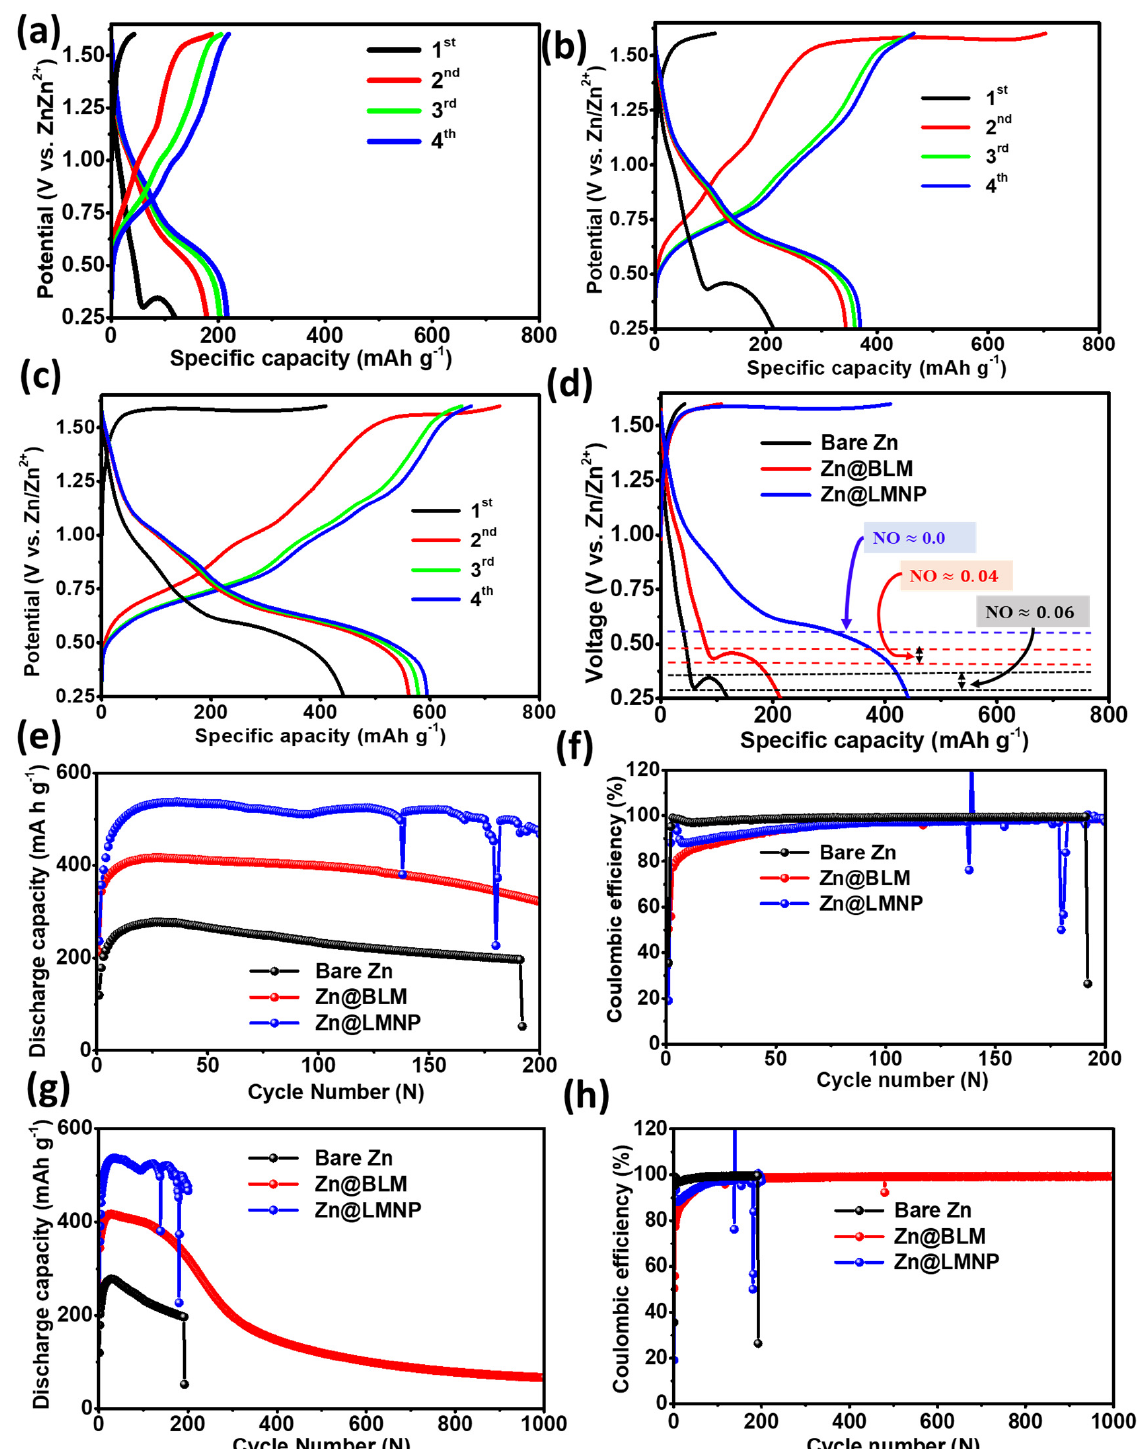
Figure 6. Potential profiles of ( a ) bare Zn, ( b ) Zn@BLM, and ( c ) Zn@LMNP electrodes coupled with V 2 O 5 @C in 2 M ZnSO 4 and ( d ) corresponding nucleation overpotential (NO) in the initial discharge